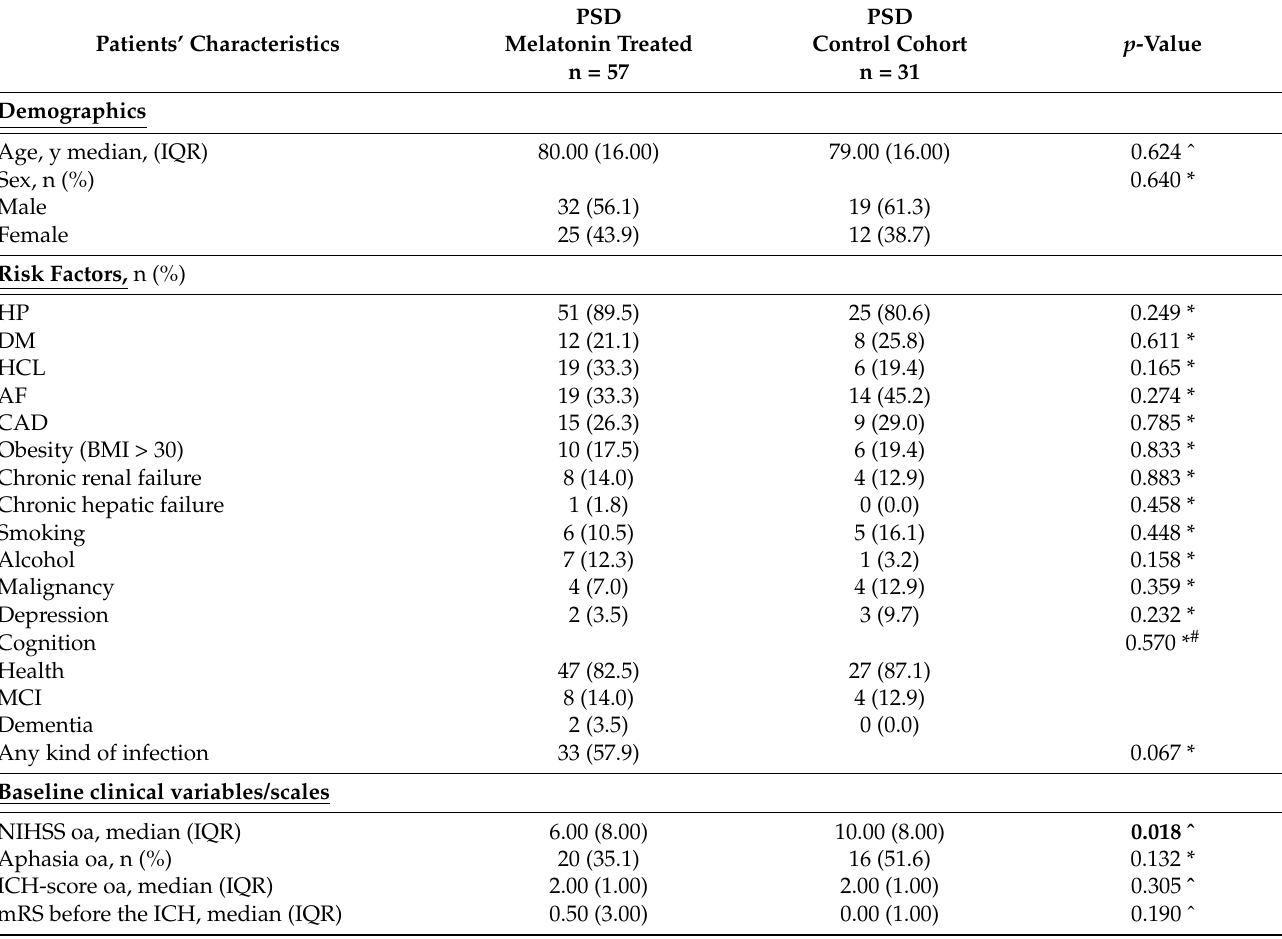
Table 3. Characteristics of patients with post-ICH PSD treated with melatonin vs. the control cohort after propensity